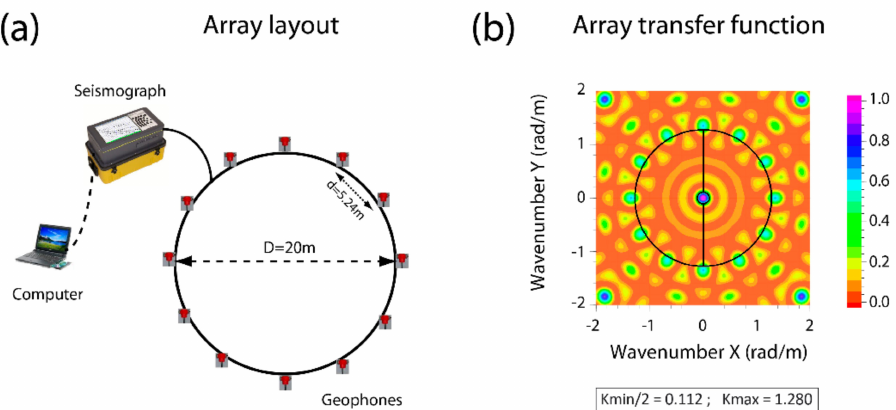
Figure 5. ( a ) Array layout; ( b ) corresponding theoretical response. The k limits corresponding to the maximum resolution (kmin/2) and the aliasing limit (kmax) are also